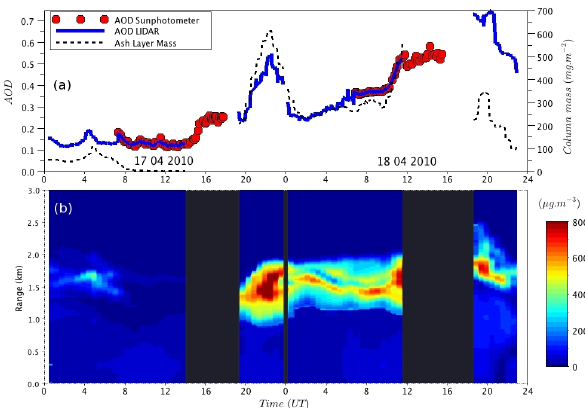
Fig. 8. Time series of (b) AMC and (a) lidar-retrieved AOD at 532 nm (in blue line), AERONET AOD at 532nm (in red) and integrated mass in mgm − 3 (in black dash line) over Lille from 17 to 18 April